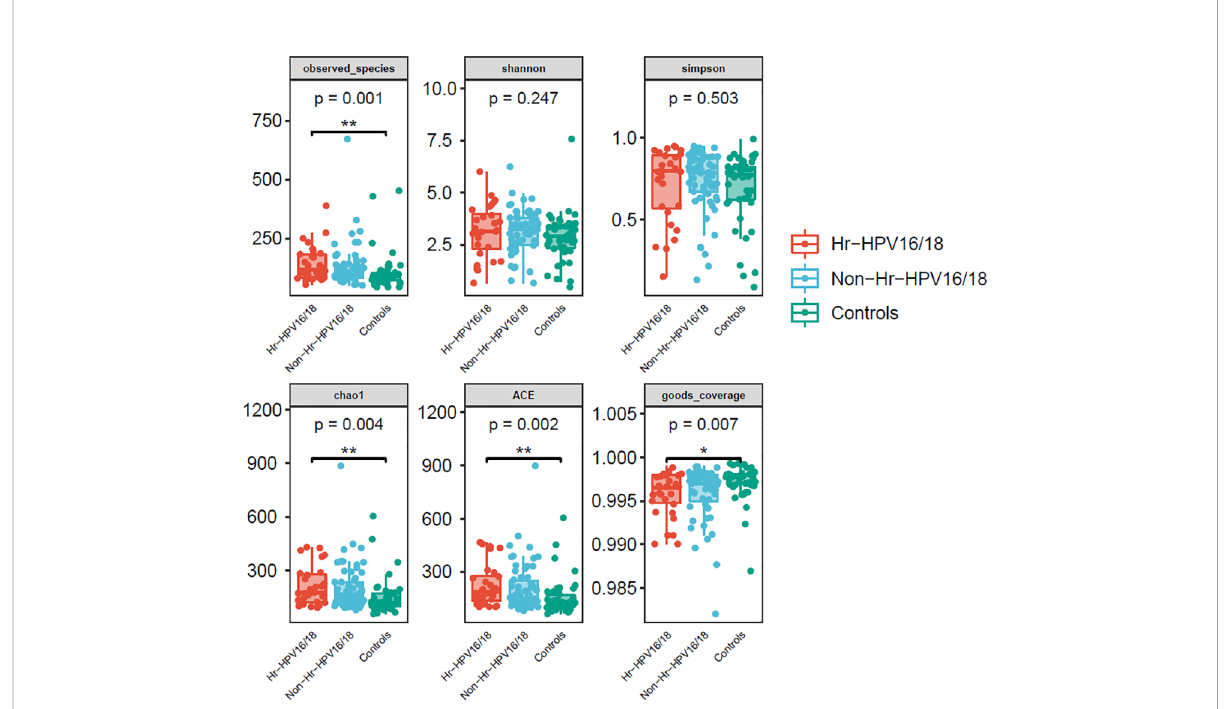
FIGURE 2 Comparison of vaginal microbial alpha diversity index (observed - species, Shannon, Simpson, Chao1, ACE, good - coverage) in infected and healthy individuals. The p -value on the top indicates the overall difference among three groups calculated using the Kruskal-Wallis nonparametric test method, and the asterisks on the top indicate a statistically signi fi cant difference between the two groups calculated using Dunn ’ s test (*p < 0.05, * *p <